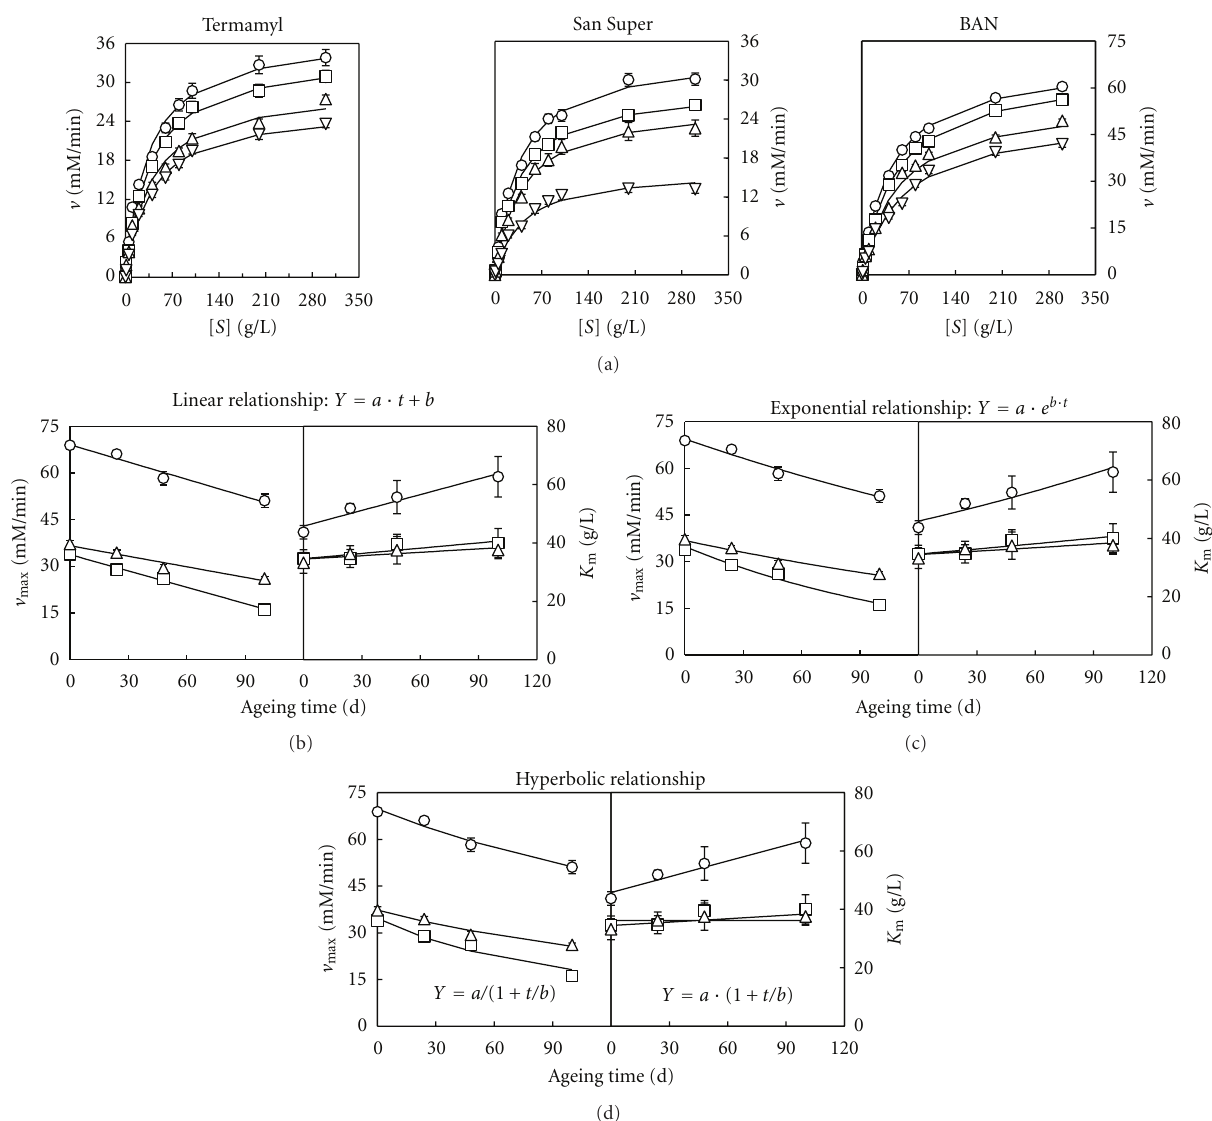
Figure 1: (a) Changes in the experimental amylolytic activity ( v ) data (means ± standard deviations) with the concentration of unaged starch (O) and starches [ S ] aged for 24h ( (cid:2) ), 48 h ( (cid:3) ), and 100 h ( ∇ ). The curves drawn through the experimental velocity data in (a) were obtained according to the Michaelis-Menten model (1). The curves drawn through the v max and K M data (as means ± standard errors) for the enzymes BAN (O), San Super ( (cid:2) ), and Termamyl ( (cid:3) ) were obtained according to a linear (b), exponential (c), and hyperbolic (d) equation. Y represents the predicted values for v max and K M , a and b are constants, and t is the ageing